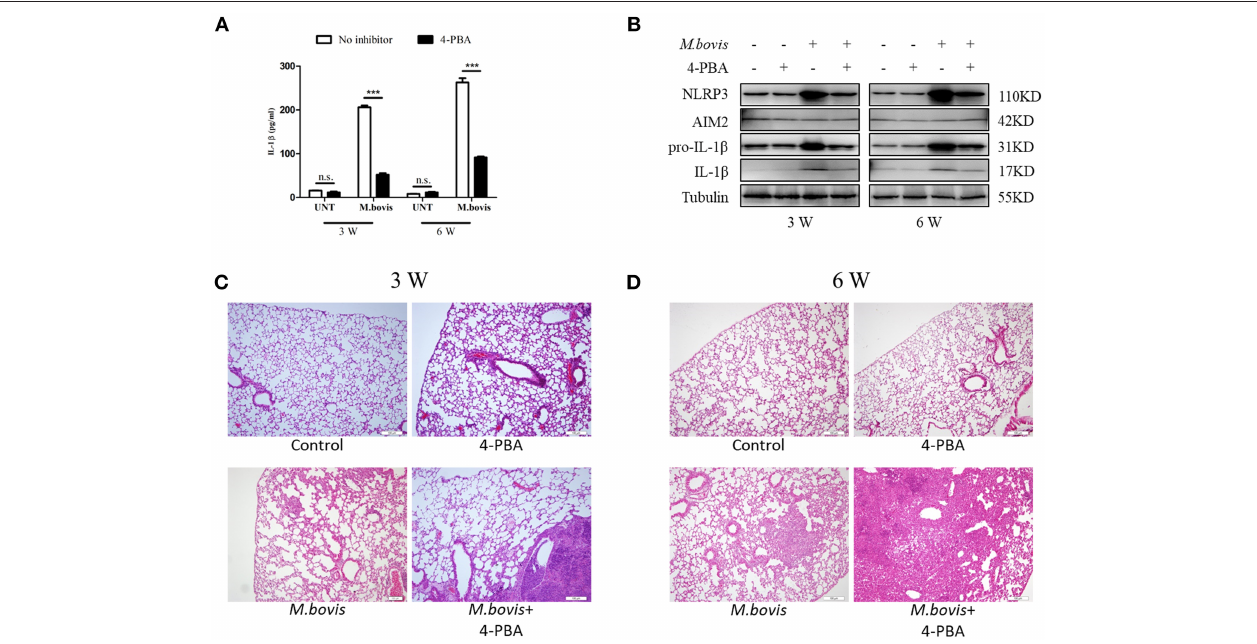
FIGURE 6 | ERS mediates M. bovis -induced inflammasome activation in vivo . (A) ELISA detection of IL-1 β in serum samples from C57BL/6 mice treated with or without 4-PBA (18.6 mg/mouse/day) and infected with M. bovis (CFU 200) ( n = 7). (B) Immunoblot analysis of NLRP3, AIM2, pro-IL-1 β , and IL-1 β in the lung tissues of M. bovis -infected mice in the presence or absence of 4-PBA. (C,D) Pathological lesions (H&E staining) in the lung of mice infected with M. bovis for 3 weeks (C) or 6 weeks (D) in the presence or absence of 4-PBA (18.6 mg/mouse/day) ( n = 3). 4-PBA, 4-phenyl butyric acid, ERS inhibitor, 18.6 mg/mouse/day; CFU, colony forming units ( n = 3). The results are shown as the mean ± SD. *** P < 0.001, n.s., not significant. P -values were analyzed by using Student’s t -test (C,D) . Scale bar = 100 µ